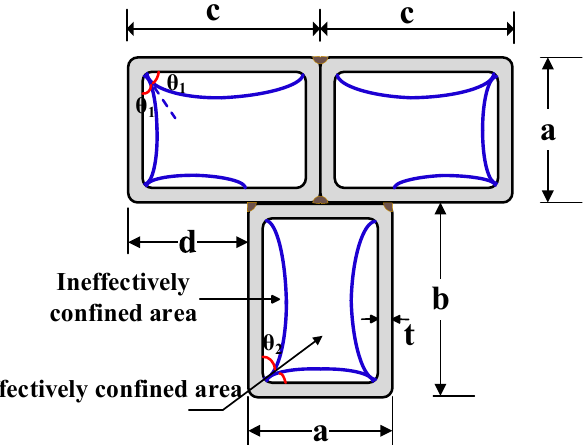
Figure 3. Division of effectively and ineffectively confined area for infilled concrete.